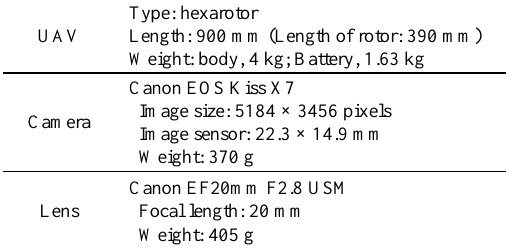
Table 1. Specifications of UAV and